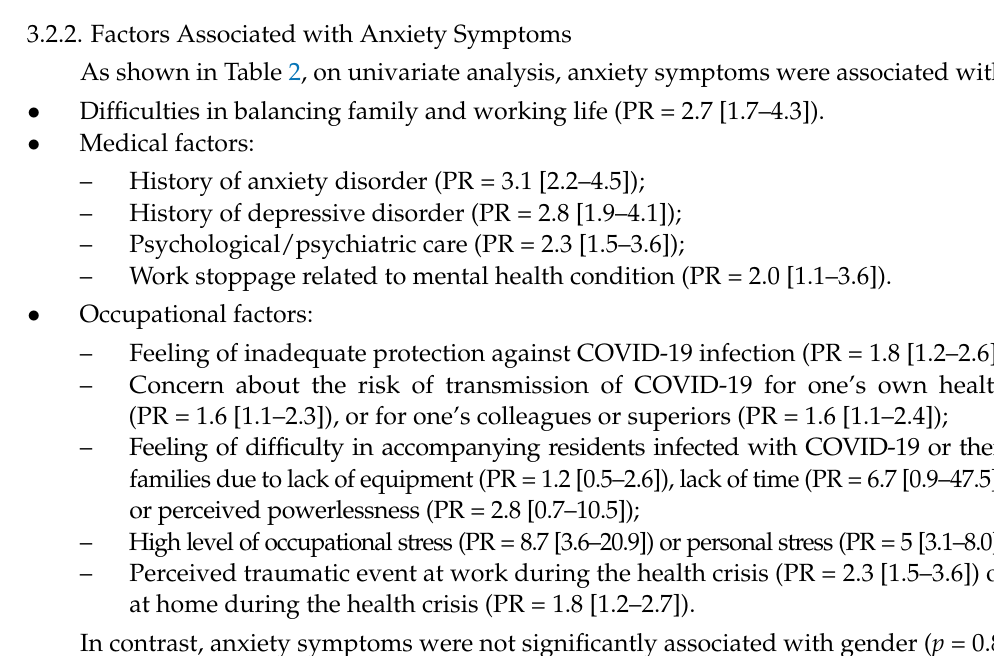
Figure 1. Causes of difficulties accompanying residents infected with COVID-19 and their